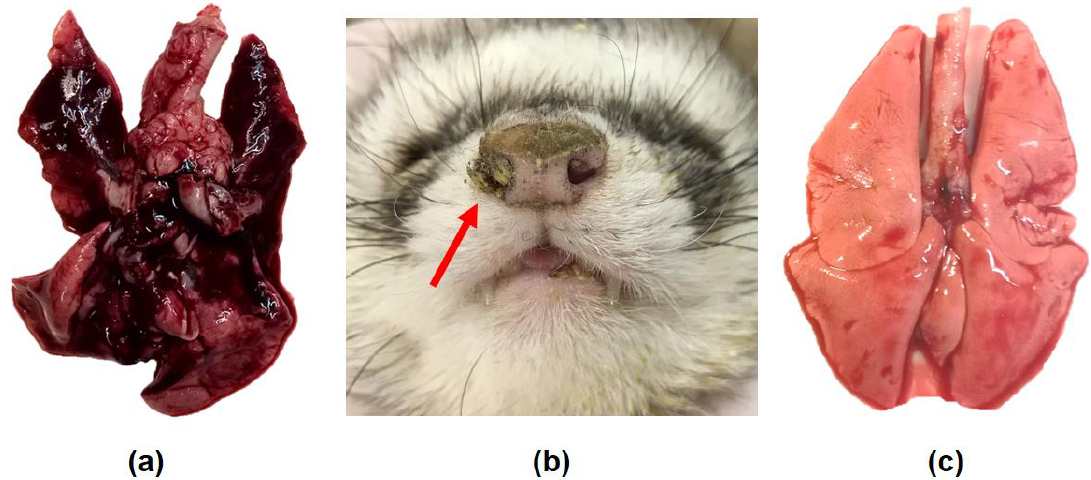
Figure 4. Nasal symptoms and gross examination of the lungs of the ferrets infected with A / South Africa / 3626 / 2013 (H1N1)pdm09 influenza virus. ( a , b ) The ferrets were inoculated with 6.0 log 10 EID 50 . ( a ) Severe lung lesions were registered on day 4 post infection. ( b ) On D3 post infection, the animals displayed sneezing, nasal discharge on the external nares (red arrow) and mouth breathing. ( c ) In contrast, the lungs of the ferrets inoculated with PBS were normal.